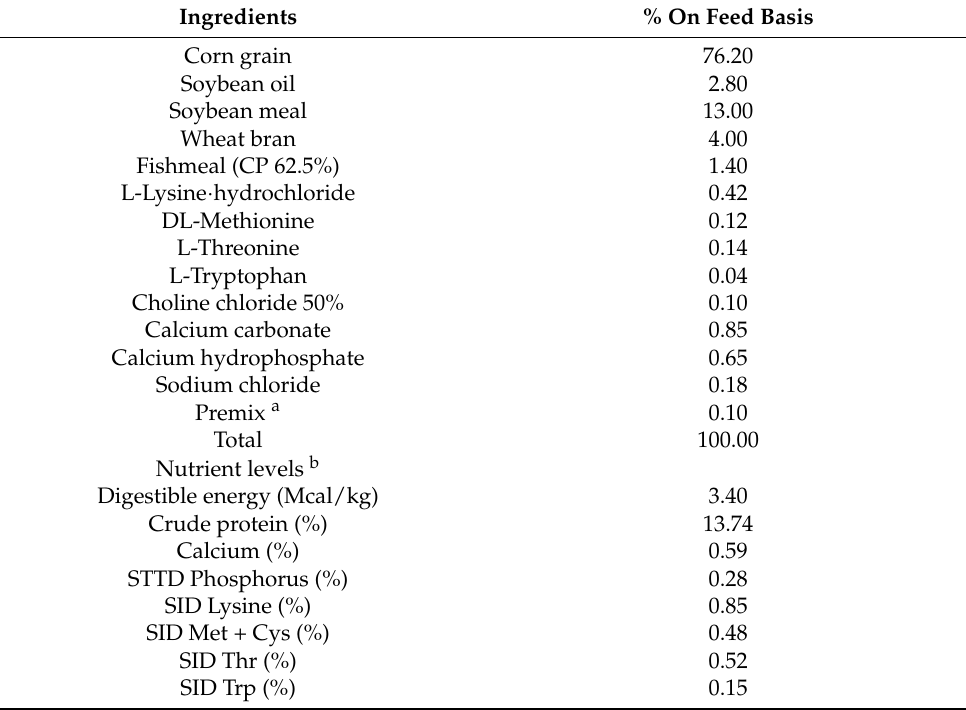
Table 1. Composition and nutrients of the basal